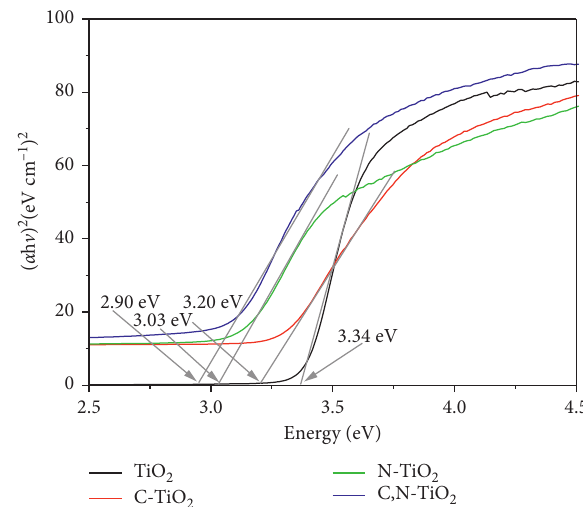
Figure 4: Plot of [ α h ] ] 2 vs h. ] for pristine TiO and C,N-TiO 2 .